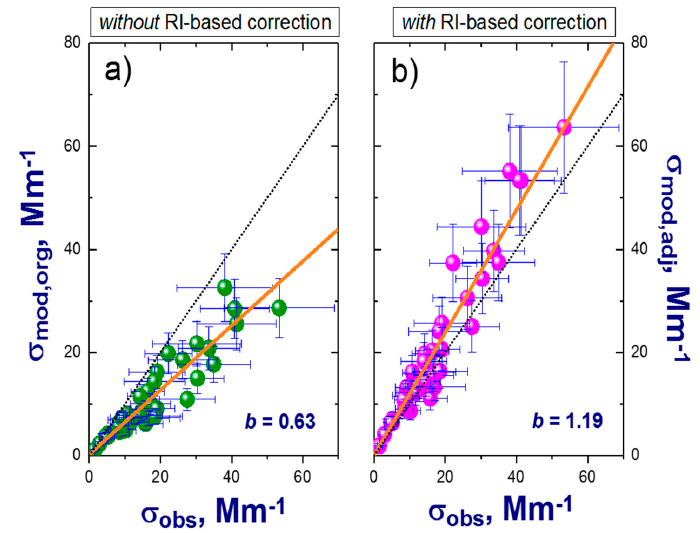
Figure 9. Comparison of the ambient total scattering coefficient observed ( σ obs ) with ambient total scattering calculated ( σ mod ) for the original ( a ) and RI-based adjusted ( b ) size distributions at 0.55 μ m wavelength for all TCAP FLs. Here b is the slope of the linear regression fits to the data (straight orange lines). Error bars represent uncertainties of measured (Section 2) and calculated (Section 3.4) scattering coefficients.